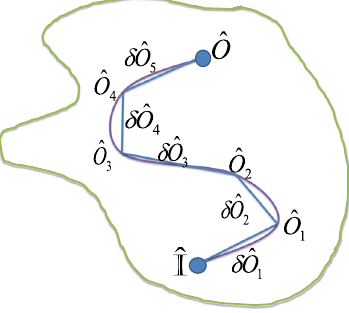
Fig. 3 A curve c ( s ) connects the identity and a particular operator ˆ O with the endpoints c ( 0 ) = ˆ I and c ( 1 ) = ˆ O . This curve can be approximated by a discrete form. Every endpoint is also an operator, which is labeled by ˆ O n